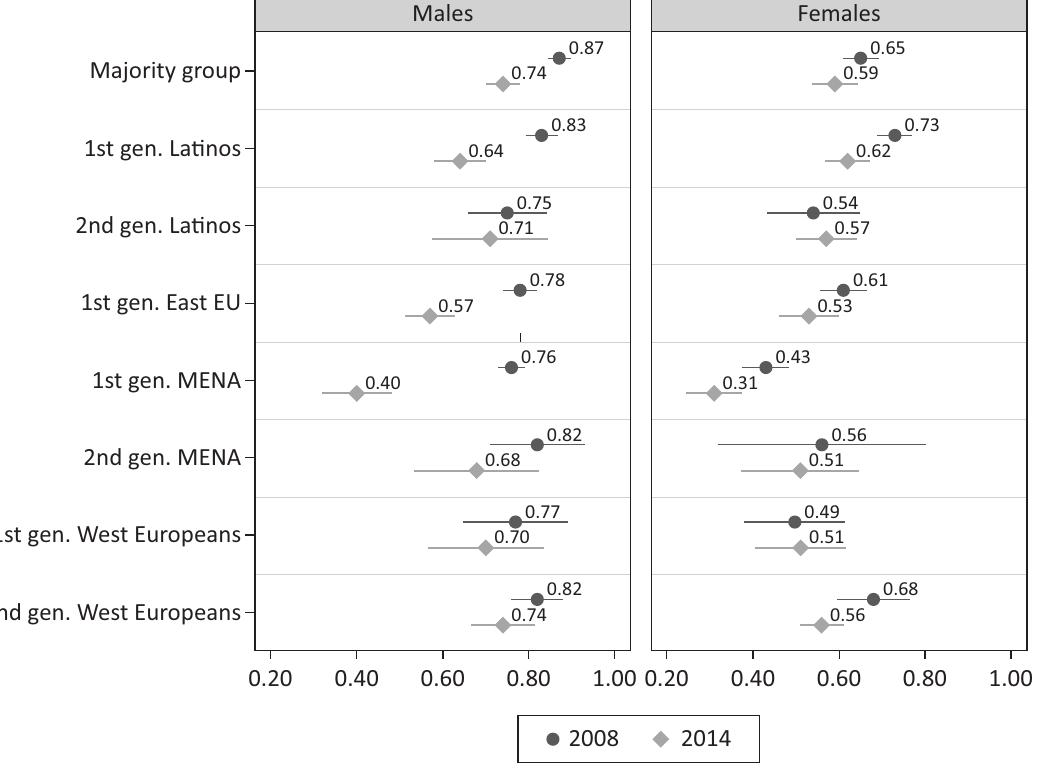
Figure 1. Predicted probabilities of paid employment for immigrants and the majority group in 2008 and 2014. Notes: Controls for age, education, civil status, dependent children and degree of urbanization; N = 114,956; age 16–64, not in education/training or retired (Full sample); bars represent 90% confidence intervals. Weighted and clustered by